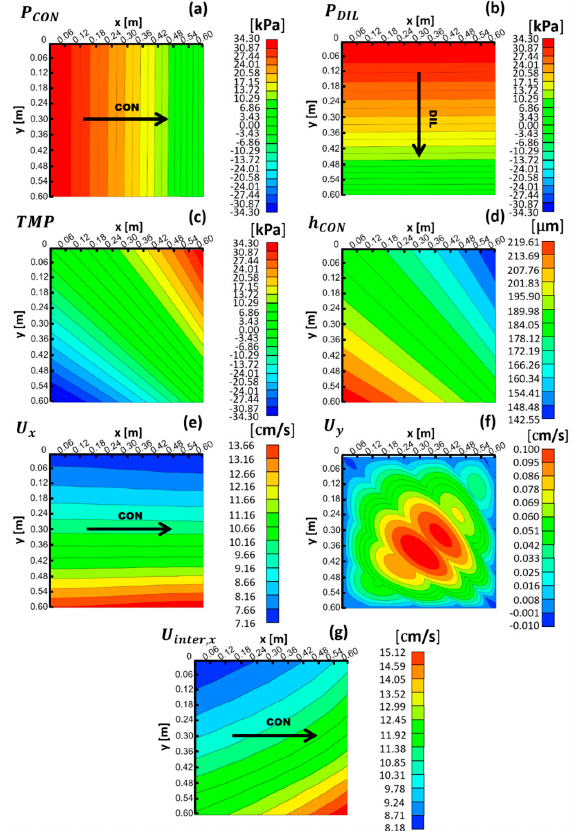
Figure 12. Results for a cross flow stack of 0.6 m sides at P in − P out = 34.3 kPa ( U s ≈ 10 cm / s) in the presence of membrane deformation: relative pressure maps for the CON ( a ) and DIL ( b ) channels, TMP ( c ), and concentrate channel equivalent height ( d ), superficial velocity components along the x ( e ) and y ( f ) directions, and interstitial velocity along the x direction ( g